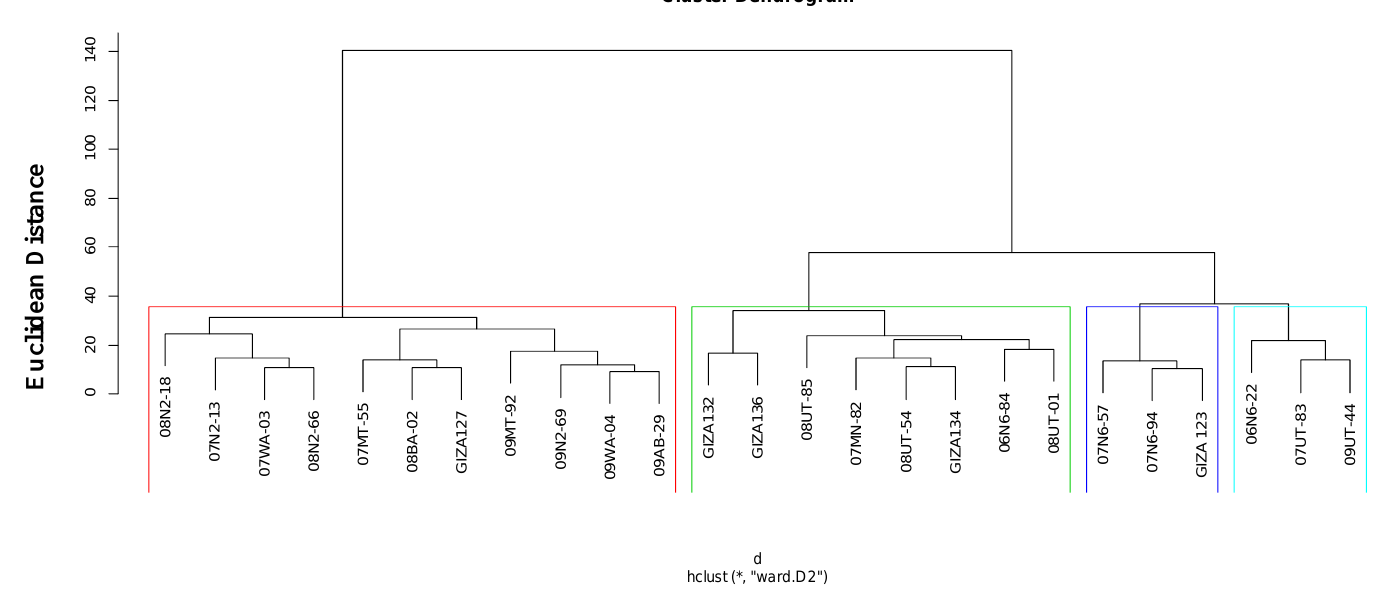
Figure 4. Dendrogram of cluster analysis of 25 barley genotypes based on morphological, physiological, and pathological traits across the three environments.